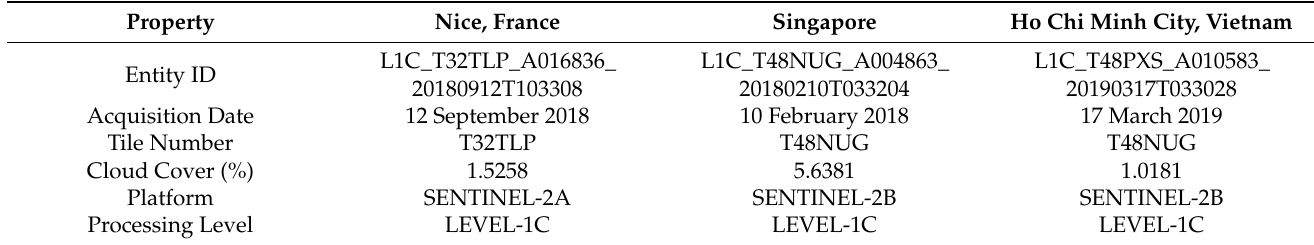
Table 2. Property of collected Sentinel-2 multispectral